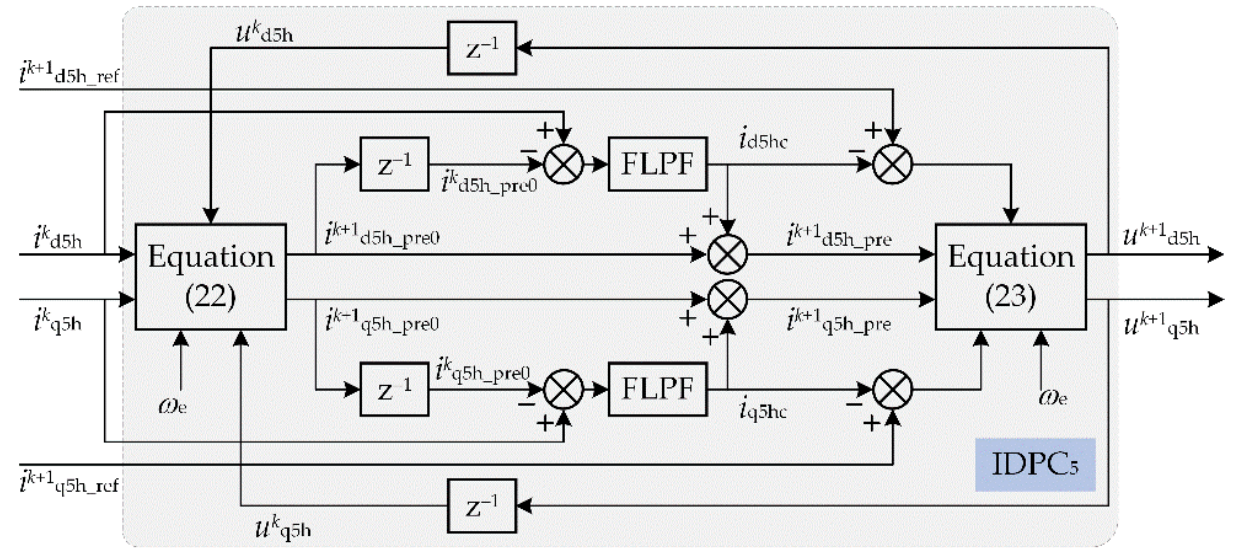
Figure 5. The block diagram of IDPC of the k th control cycle in the 5th synchronous rotating frame. Similarly, in the k th control cycle, the IDPC mathematical model in the 7th synchronous ro- tating frame can be expressed as Equations (26) and (27), and the IDPC block diagram in the 7th synchronous rotating frame including the current compensation scheme is shown in Figure 6.